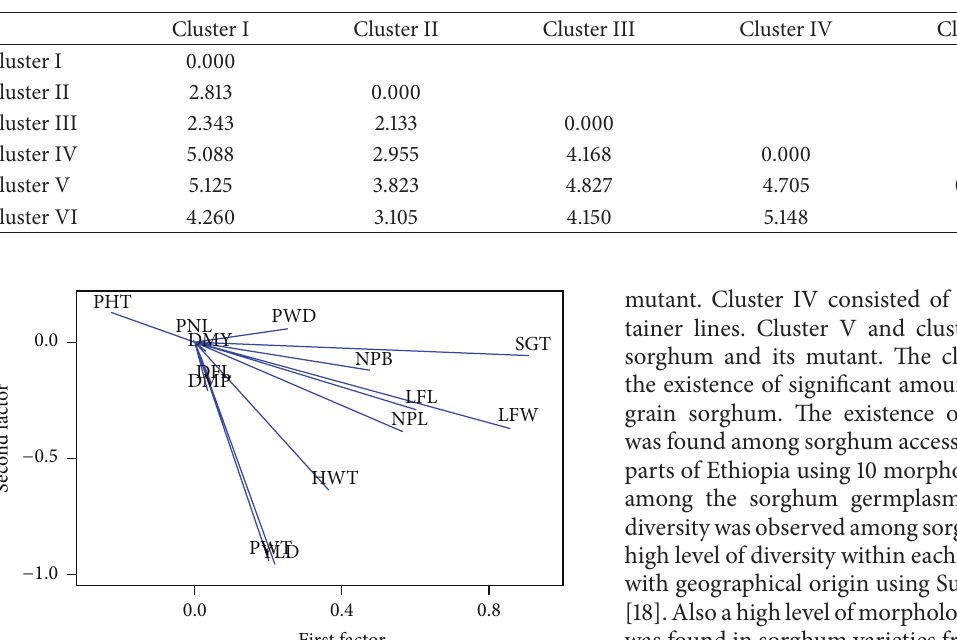
Table 6: Intercluster distances among sorghum accessions.